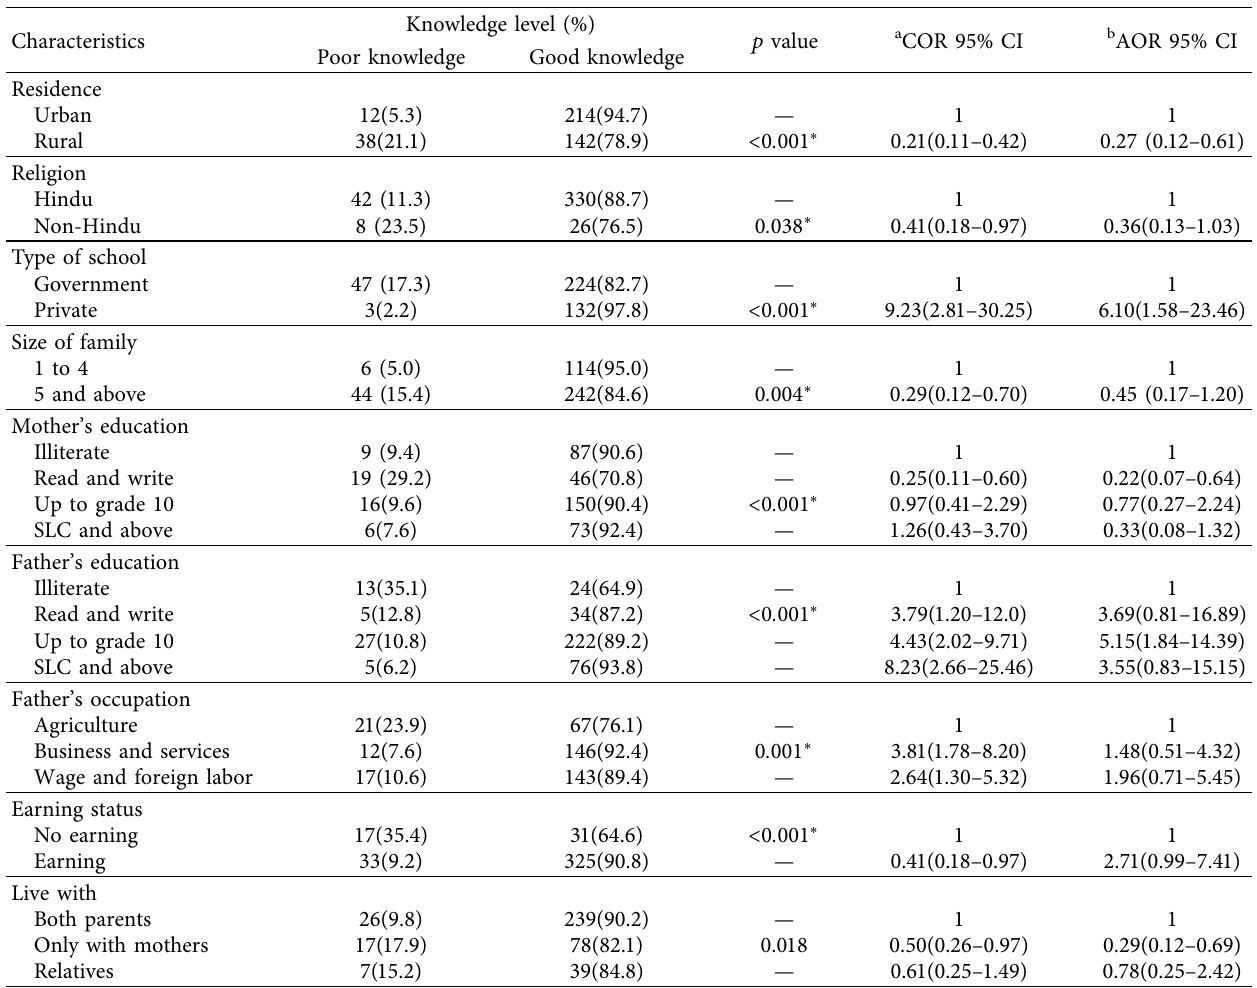
Table 4: Factors associated with level of knowledge in bivariate and multivariate